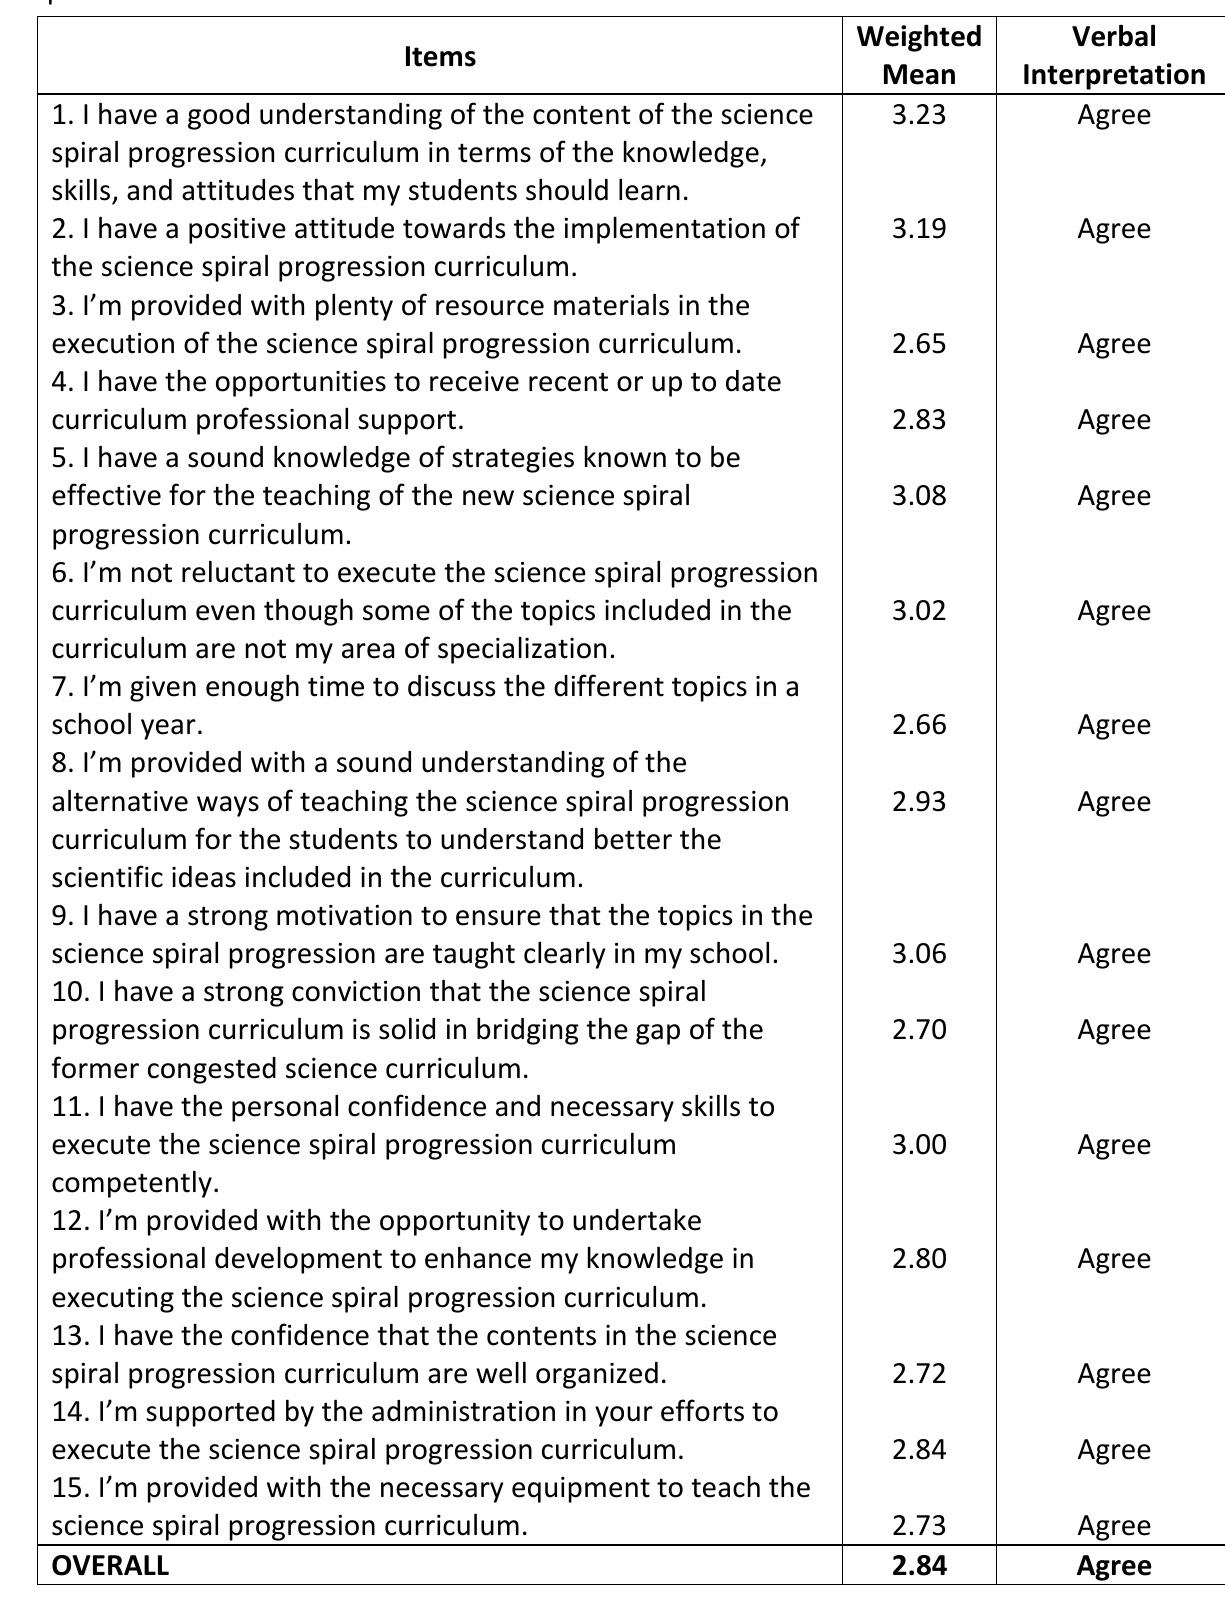
Table 2 : Weighted Means of the Perspectives of Science Teachers in Executing the Science Spiral